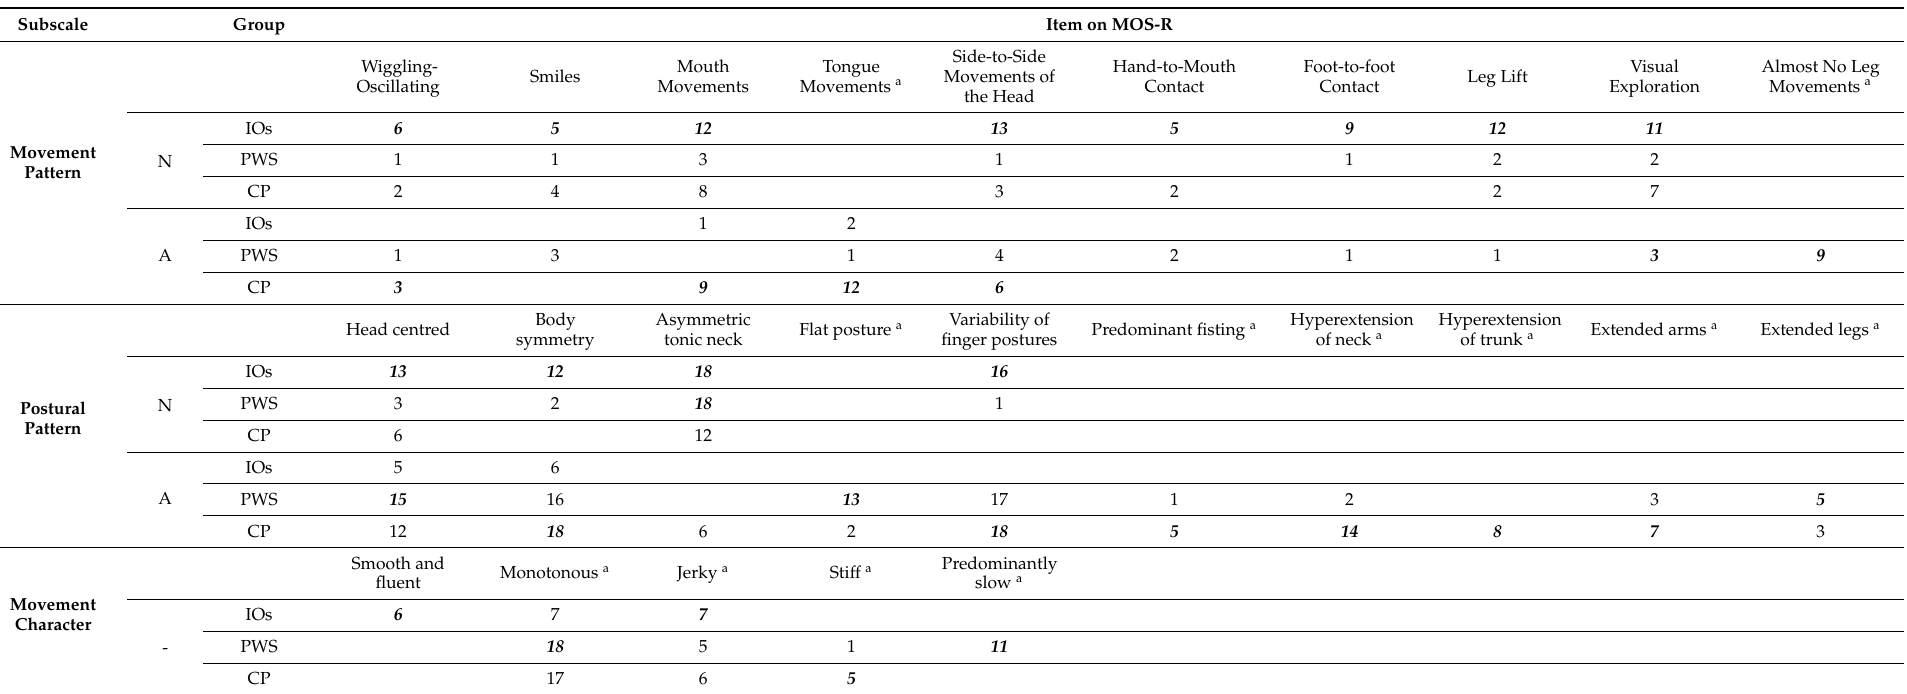
Table 3. Frequently observed normal (N) vs. abnormal (A) Movement patterns, postural patterns, and movement characters in the three groups of infants (with inconspicuous developmental outcomes, IOs; Prader-Willi syndrome, PWS; or cerebral palsy, CP). Each group had 18 cases. An MOS-R item is listed only if it was observed in at least five infants in one of the three groups. Numbers indicate the observed frequency. The cell is left empty if the pattern was not observed in the respective group. The highest frequency among the three groups for the respective comparison is formatted bold and